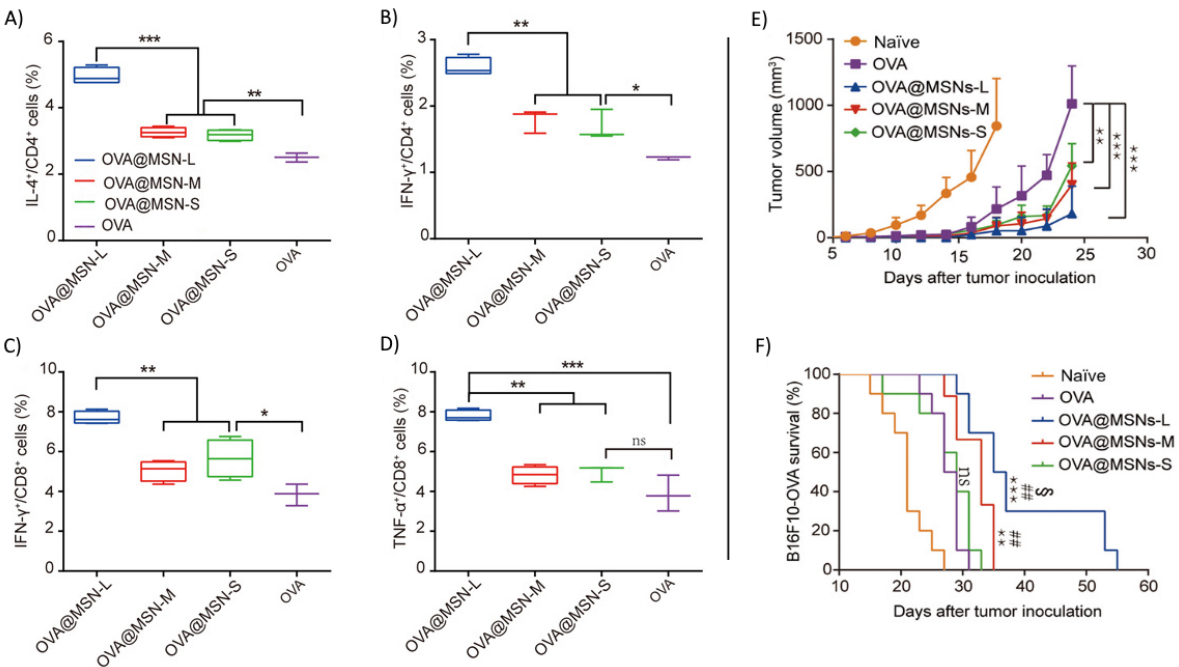
Figure 7. Small MSN of varying pore size loaded with OVA antigen. ( A , B ) Percentage of CD4 + T cells producing IL-4 and IFN- γ . ( C , D ) Percentage of CD8 + T cells producing IFN- γ and TNF- α . ( E ) Tumor growth curve of B16F10 cells. ( F ) Kaplan-Meier survival curve of mice comparing naïve, free OVA, and OVA@MSN. Error bars, mean ± s.d., * p < 0.05, ** p < 0.01, *** p < 0.001 versus free OVA; ## p < 0.01 versus OVA@MSNs-S; § p < 0.05 versus OVA@MSNs-M. Reprinted (adapted) with permission from Ref. [130]. Copyright 2021,